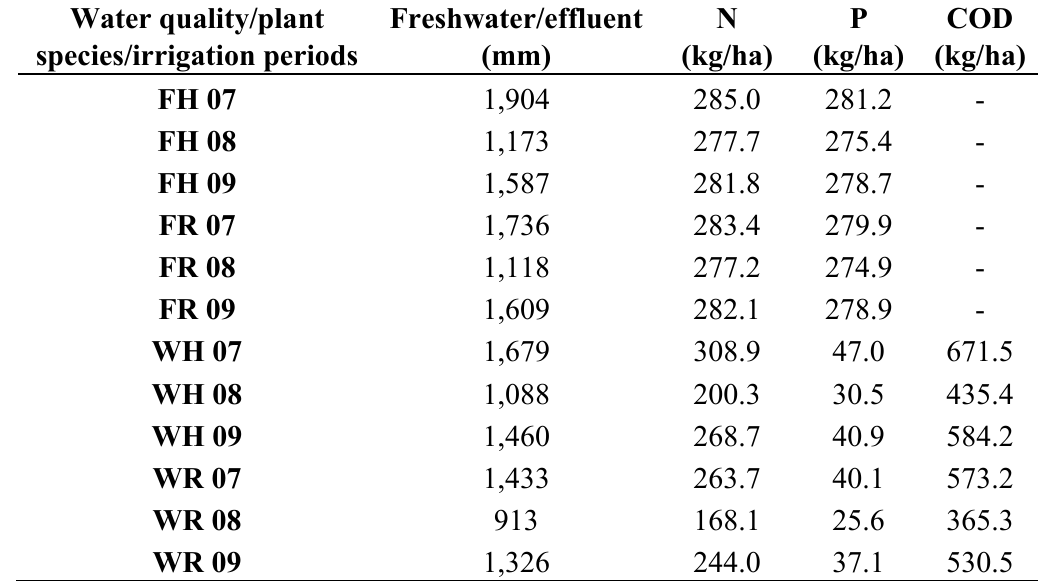
Table 2. Hydraulic, N, P, and COD loads applied to freshwater and effluent irrigated